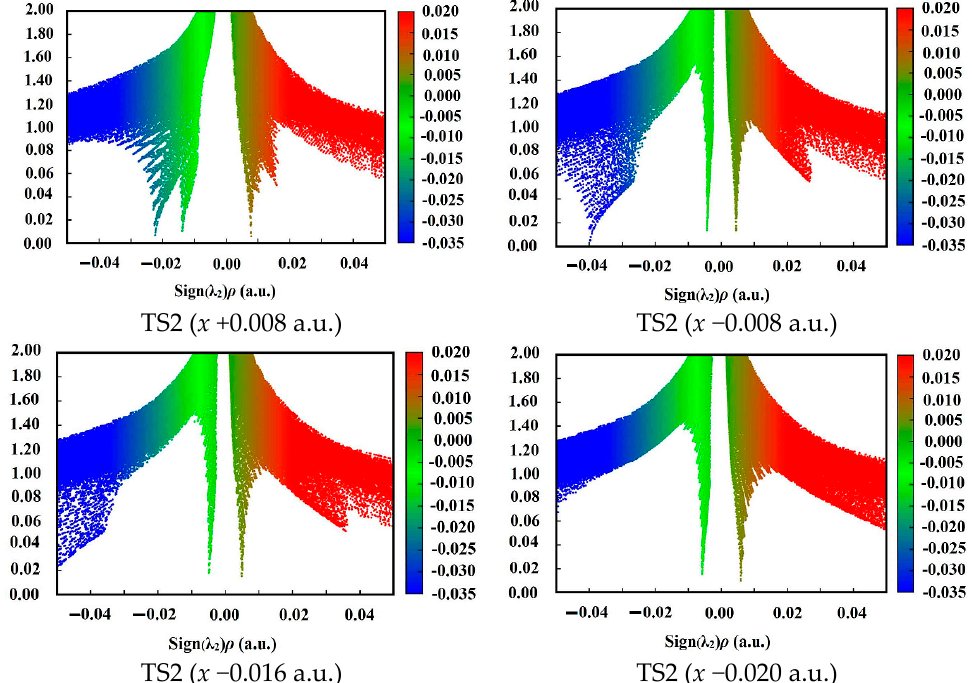
Figure 4. Plots of the RDG versus the electron density multiplied by the sign of the second Hessian eigenvalue ( λ 2 ) for TS1 and TS2. Green indicates strong attractive interaction, blue-brown indicates weak attractive interaction or vdW interaction, and red indicates steric effect.